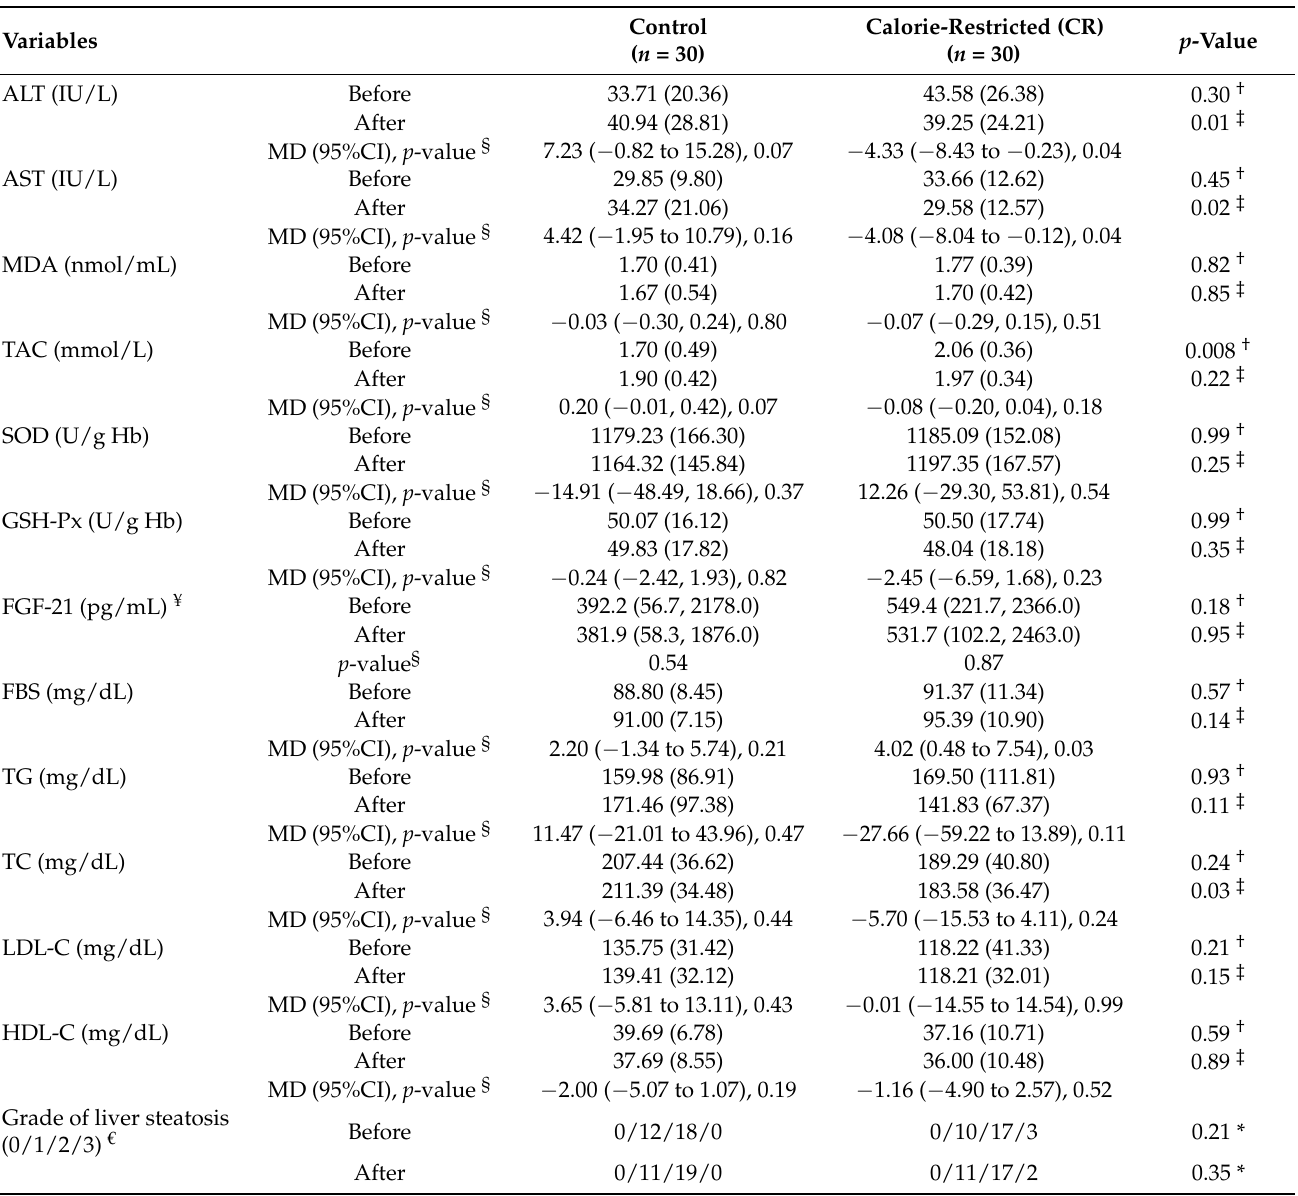
Table 3. Biochemical parameters and liver steatosis grades of the study patients at baseline and after the 12-wk